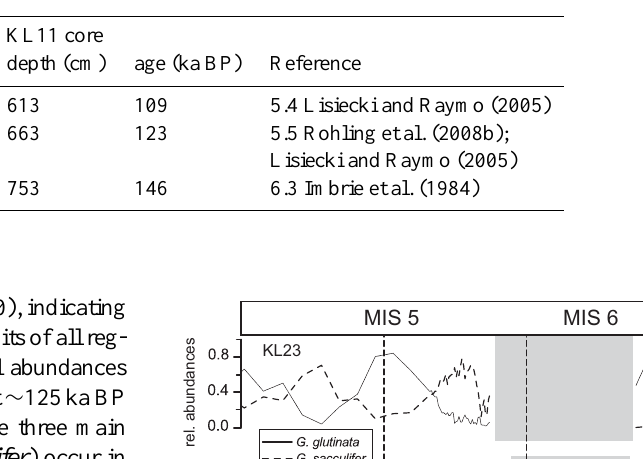
used thresholds for the application of transfer functions